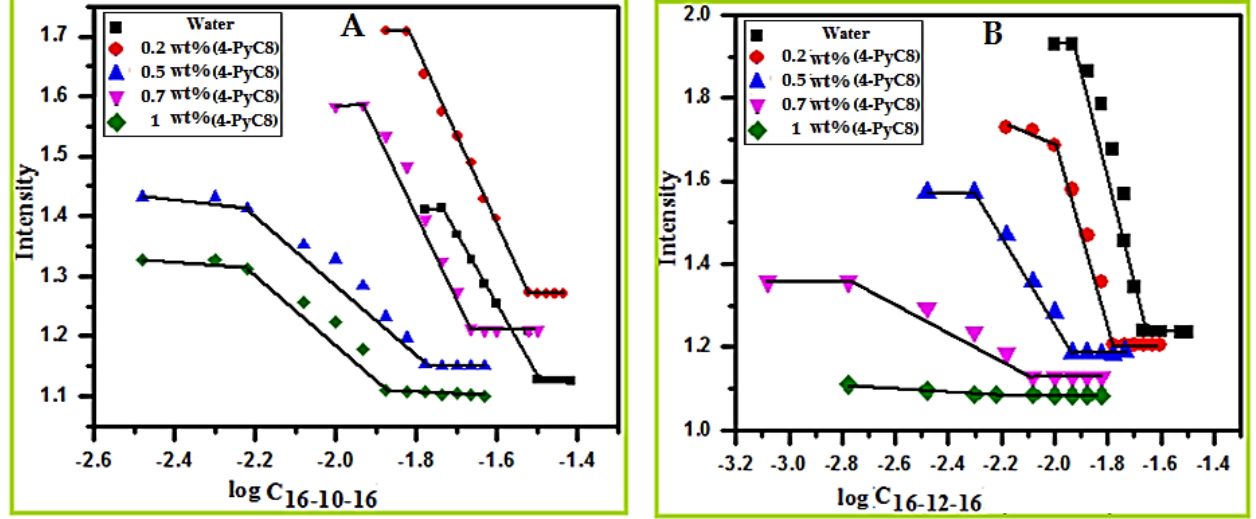
Figure 3. Intensity of the fluorescence vs. the logarithm of the concentration of the gemini surfactants 16-10-16 ( A ) and 16-12-16 ( B ) in water and in the presence of the IL 4-PyC8 at 300 K. The excitation wavelength was 334 nm and both excitation and emission slit widths were kept at 2